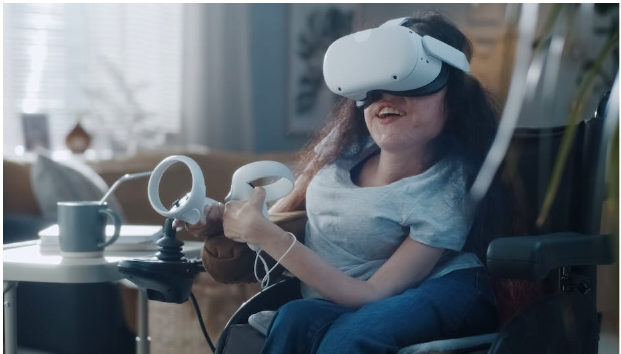
Figure 40: Metaverse Fashion Week, Decentraland Metaverse Figure 38: Source: Five ways the metaverse could be revolutionary for people with disabilities (Brunel University, Art in the Metaverse London)